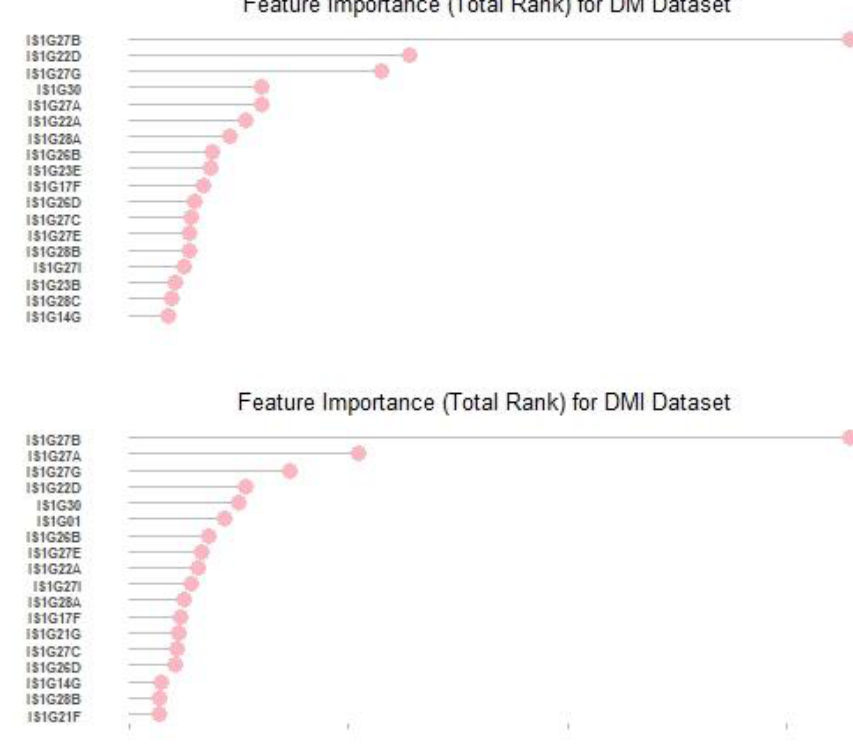
Figure 2. The top 10% influential factors for DM and DMI datasets.